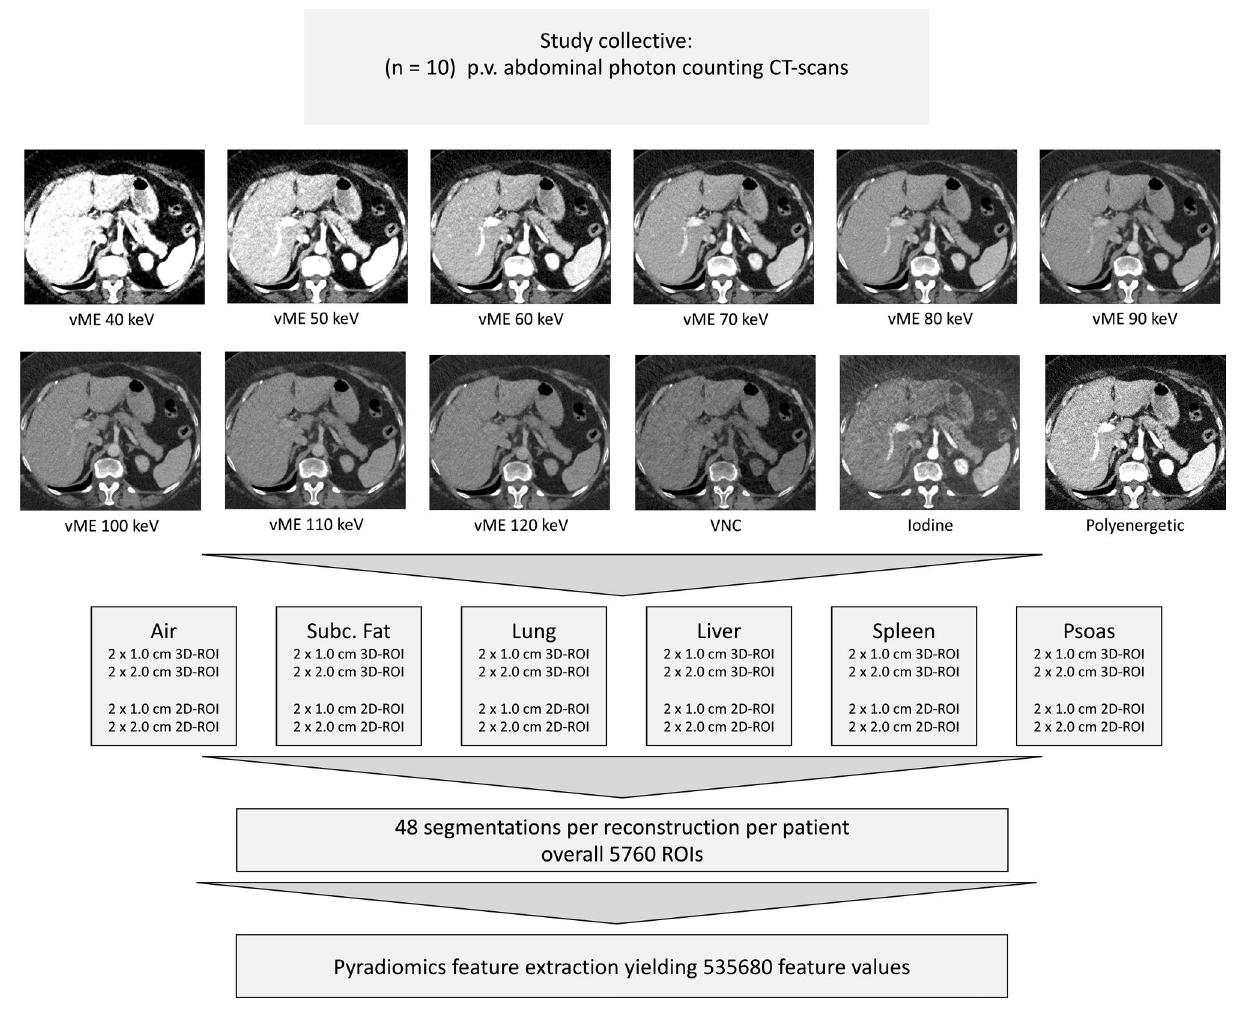
Figure 1. Study protocol.